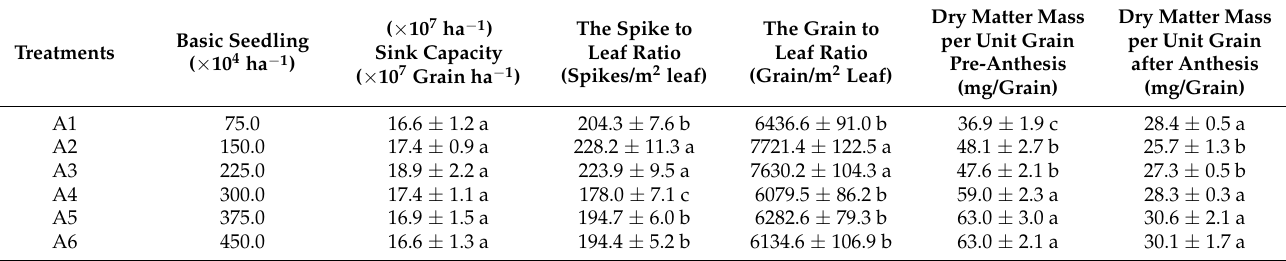
Table 6. Characteristics of sink–source system of hybrid wheat with different densities.